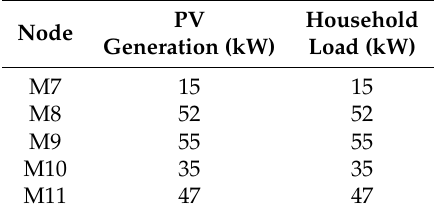
Table 3. Peak power of loads and generators connected in each node of the LV original distribution network.